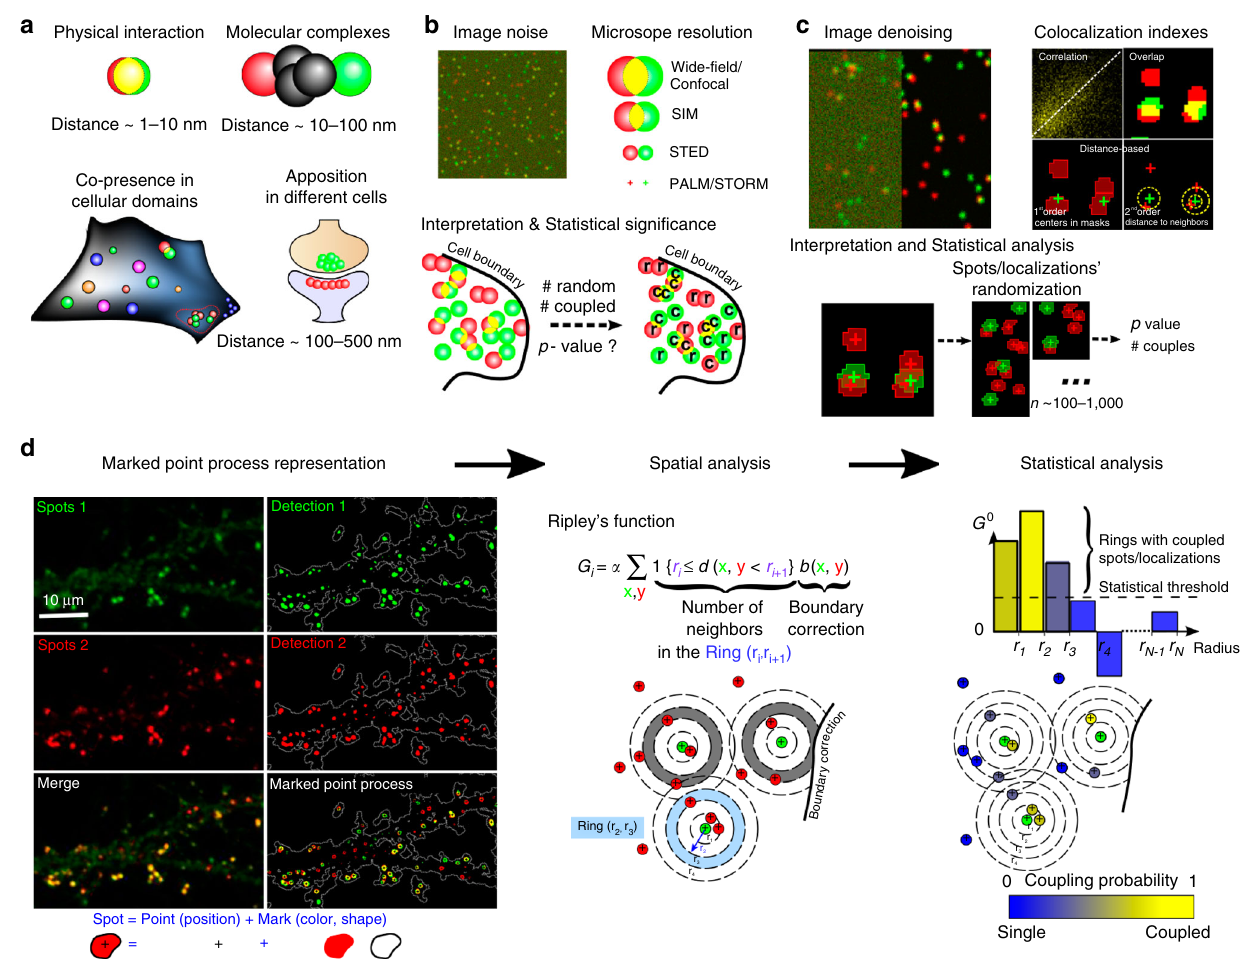
Fig. 1 Co-localisation analysis of molecules ’ coupling. a Molecules ’ coupling embraces direct interaction (distance < 10 nm), indirect interaction inside a macromolecular complex (distance between 10 and 100 nm), co-presence in cellular domains and synaptic apposition (distance between 100 and 500 nm). b Issues in co-localisation analysis are: (i) the sensitivity of co-localisation coef fi cients to noise, (ii) the dependence of methods on microscope resolution and (iii) the unbiased interpretation and statistical signi fi cance of co-localisation coef fi cients, as signal overlap/correlation can happen by chance for randomly distributed spots. Here for example, labels r and c designate random and coupled spots respectively. c Main steps of co-localisation analysis are: (i) image denoising and spots ’ extraction, (ii) quanti fi cation of the co-localisation of fl uorescent signals, which can be evaluated with various techniques (correlations methods, physical overlap, distance-based index, see Table 1 for a detailed review of indexes), and (iii) statistical analysis of measured index with pixel/spots ’ randomisation. d SODA principles: (i) Molecules are labelled with different fl uorescent probes (Homer (green spots 1) and PSD95 (red spots 2) are observed here with a confocal microscope). Fluorescent spots are automatically detected and represented with a Marked Point Process: the point is the spot ’ s localisation (centre of mass or intensity) and the mark embraces morphological properties as the size and the colour of the spot. The ROI boundary is highlighted with a white dashed line. (ii) Spatial coupling between spots 1 and 2 is quanti fi ed with the Ripley ’ s K function that counts the number of spots in channel 2 (red spots) that are in concentric rings around channel 1 spots (green spots) (Material and Methods, and Table 2). A boundary term corrects the under counting of neighbours near the boundary. (iii) Statistical thresholding (black dashed line) of the (reduced) Ripley ’ s function indicates the rings where (red) spots 2 accumulate signi fi cantly. The number of coupled spots in each ring is proportional to the overshoot of the Ripley ’ s function over the threshold. The coupling probability for each pair of spots is deduced from the ratio between the number of coupled (red) spots and the total number of (red) spots in each